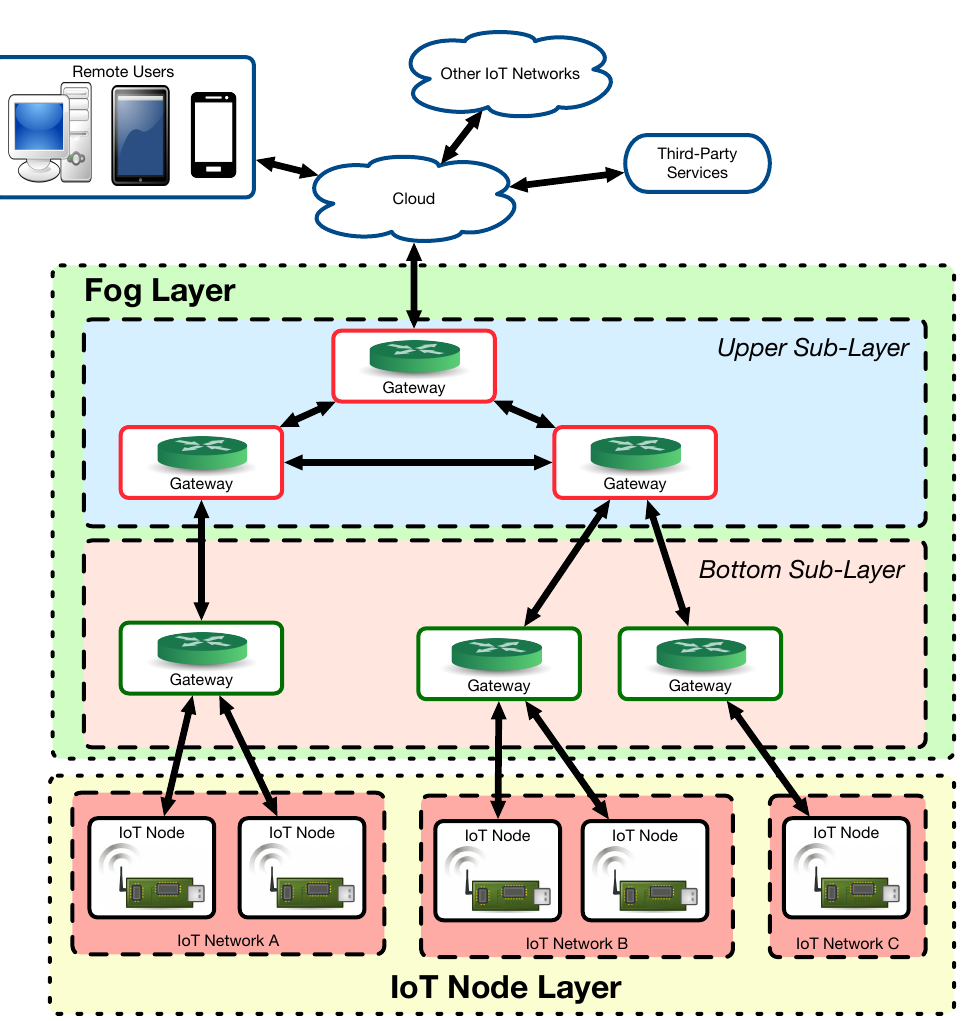
Figure 2. Generic fog computing